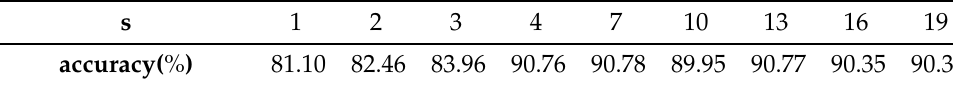
Table 3. The performance of AM-softmax with different scales.